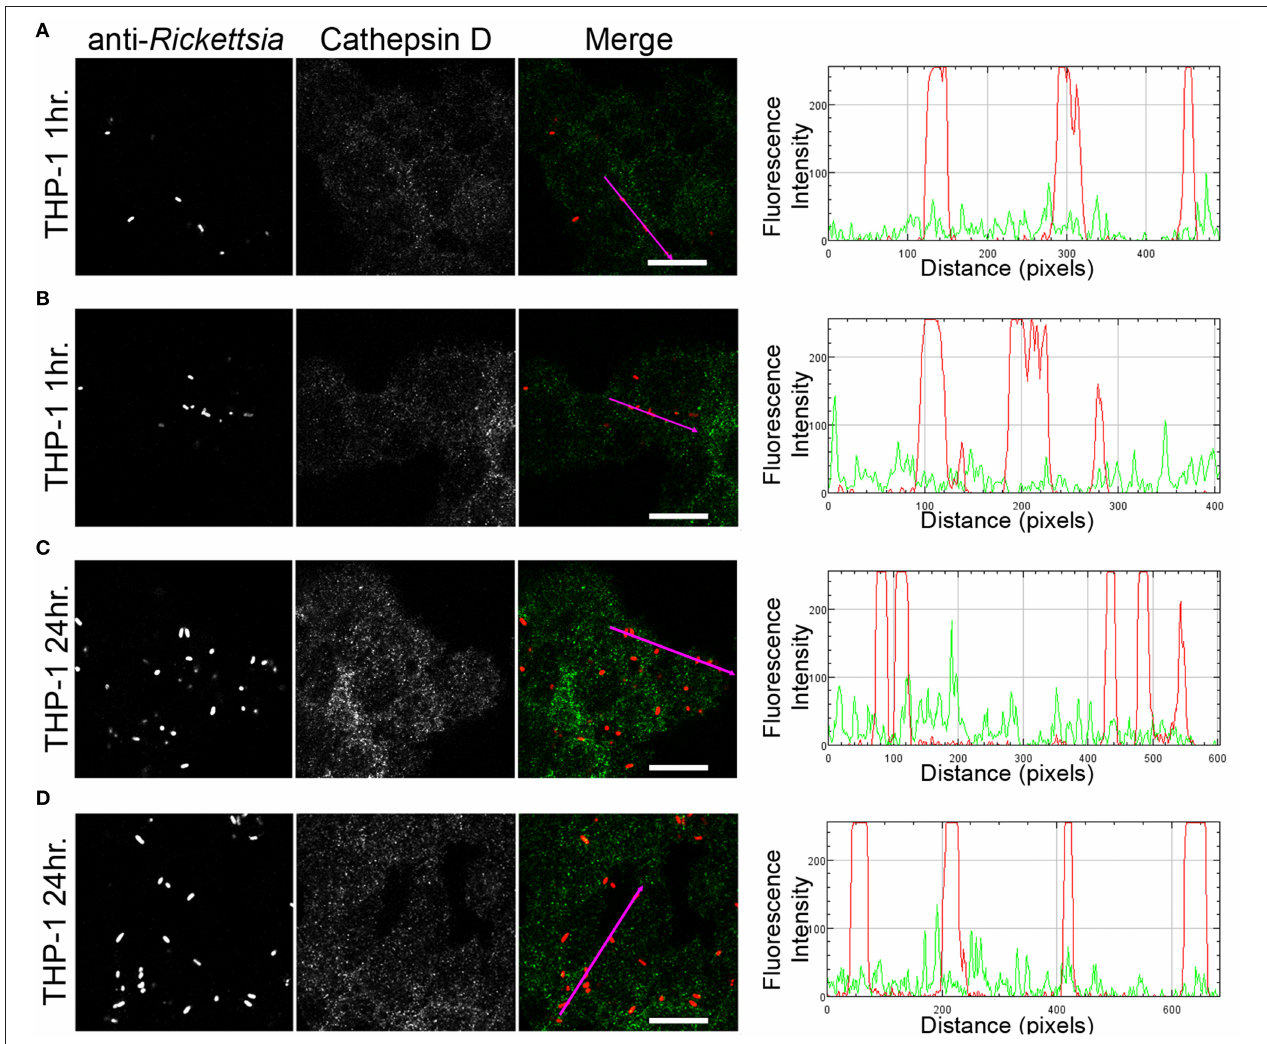
FIGURE 8 | R. conorii shows no substantial co-localization with the lysosomal marker cathepsin D. THP-1-derived macrophages were infected with R. conorii (MOI = 10). At 60 min or 24 h post infection, cells were fixed, permeabilized, and double stained for immunofluorescence confocal microscopy analysis with anti-Rc PFA followed by Alexa Fluor 546 (red) to stain R. conorii , and the monoclonal antibody for cathepsin D followed by Alexa Fluor 488 (green). (A–D) Representative images of a single slice from the z stacks of THP1-derived macrophages at 60 min post infection (A,B) and 24 h post infection (C,D) . Each row shows, from left to right, Rickettsia staining, cathepsin D staining, the merged image, and a RGB plot profile illustrating the fluorescence intensity along the magenta arrow. Scale bar = 10 µ m. Supplementary Movies 11, 12 represent 360 ◦ rotation movie of the 3D projection of the stack images shown in (B) and (D) ,